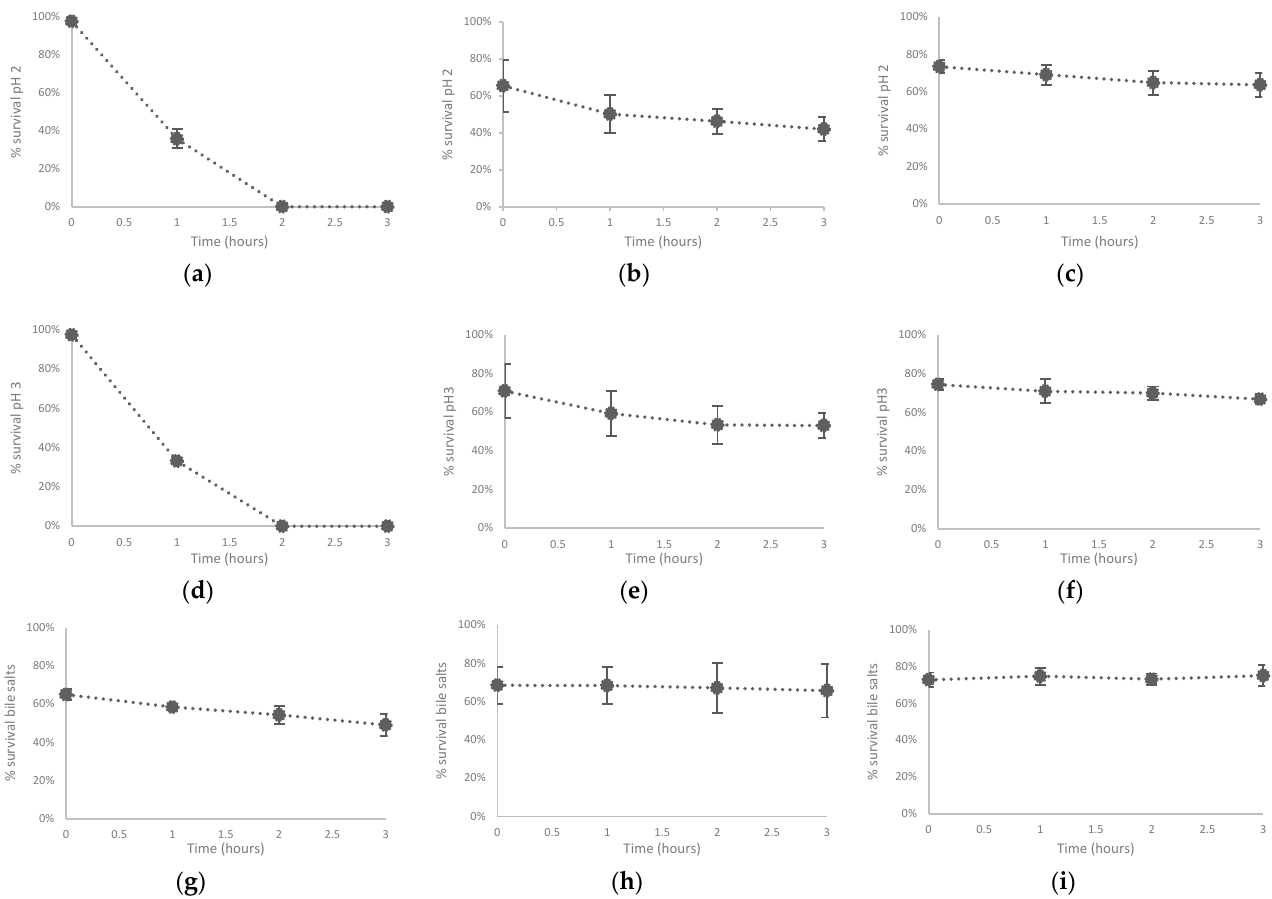
Figure 5. Evaluation of the survival to gastrointestinal conditions such as low pH (2 and 3) and bile salts of L. lactis A12, P. megaterium , Priestia sp . M10. ( a ): % survival pH 2 L. lactis A12, ( b ): % survival pH 2 P. megaterium M4, ( c ): % survival pH 2 Priestia sp . M10, ( d ): % survival pH 3 L. lactis A12, ( e ): % survival pH 3 P. megaterium M4, ( f ): % survival pH 3 Priestia sp . M10, ( g ): % survival bile salts L. lactis A12, ( h ): % survival bile salts P. megaterium M4, ( i ): % survival bile salts Priestia sp . M10.